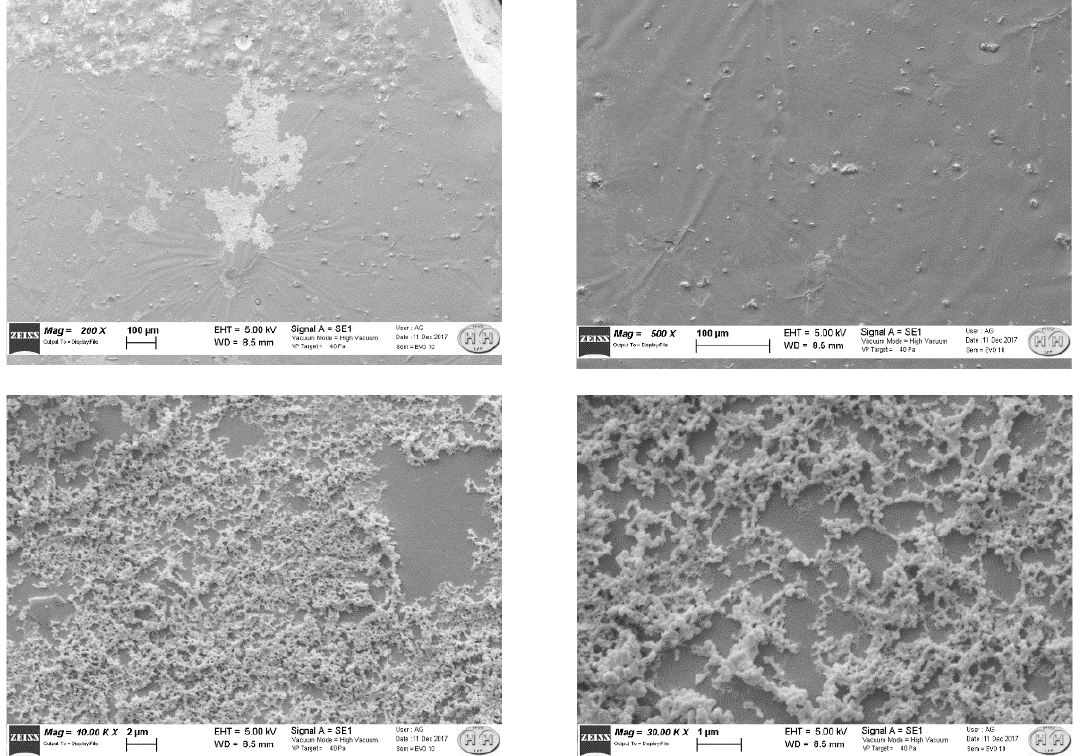
Figure 3. SEM images of different points at the surface of the sensing part.